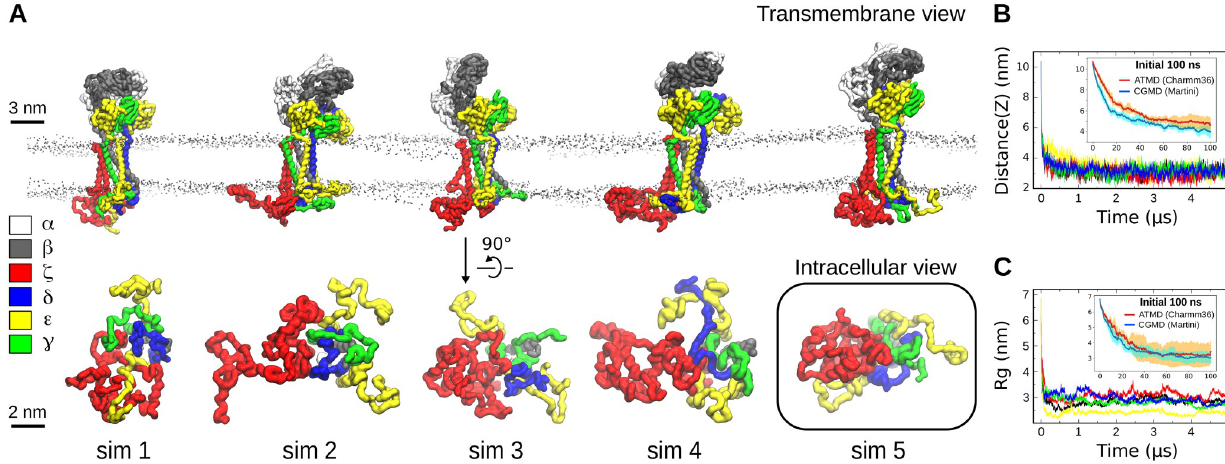
Fig 2. Association of the TCR-CD3 cytoplasmic region with the membrane. (A) Side view of the entire TCR-CD3 (top) and intracellular view of its cytoplasmic region (bottom) taken from the end of the five CGMD simulations of membrane 1. The box highlights the most common CYR conformation calculated by the clustering analysis. (B) Distances between the center of mass (COM) of the TCR-CD3 CYR and the COM of membrane 1 calculated from the five CGMD simulations along the vertical (Z) axis versus time. (C) Radius of gyration (Rg) of the TCR-CD3 CYR versus time from all CGMD simulations. In (B) and (C), distance(Z) and Rg were also calculated from ATMD simulations performed for 100 ns. Comparison of the average distance(Z) and Rg between the ATMD (red) and CGMD (blue) simulations is shown in the inset graph. Standard deviation is shown in cyan for CGMD and in orange for